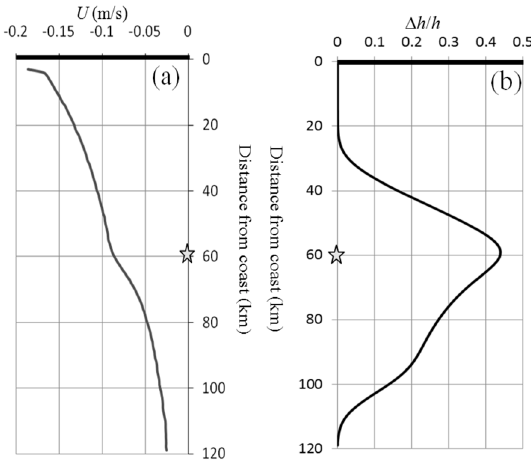
Figure 4. Control experiment: ( a ) offshore structure of ambient along-shore geostrophic flow; and ( b ) maximum possible water-column stretching ∆ h / h ( ∆ h , canyon depth; h , ambient total water depth). The star indicates the location of the shelf break.